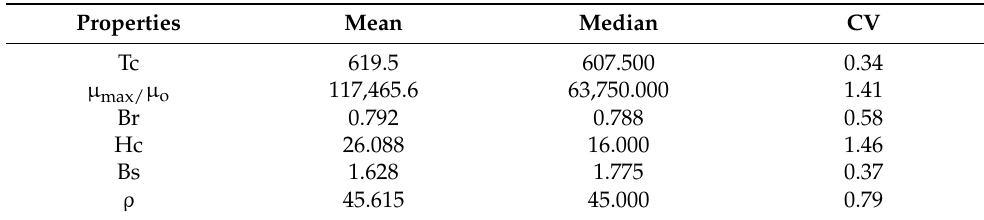
Table 2. Mean, Median and Coefficient of variance of physical characteristics of soft magnetic materials.